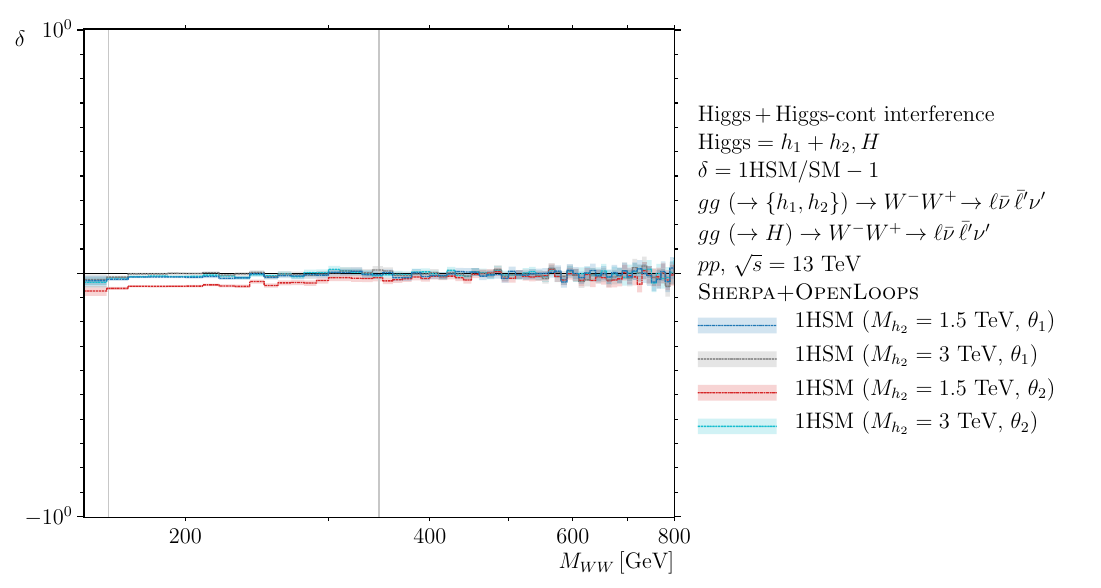
M WW distributions of the relative deviation δ = R 1 of the Higgs cross section − = 1 . 5 , 3 TeV, θ 1 , θ 2 ) compared 2 { } { } ) W − W + (cid:22) ¯ ν ¯ (cid:22) (cid:30) ν (cid:30) in pp collisions at √ s = 13 TeV. R is the h 1 , h 2 , H } → → → {